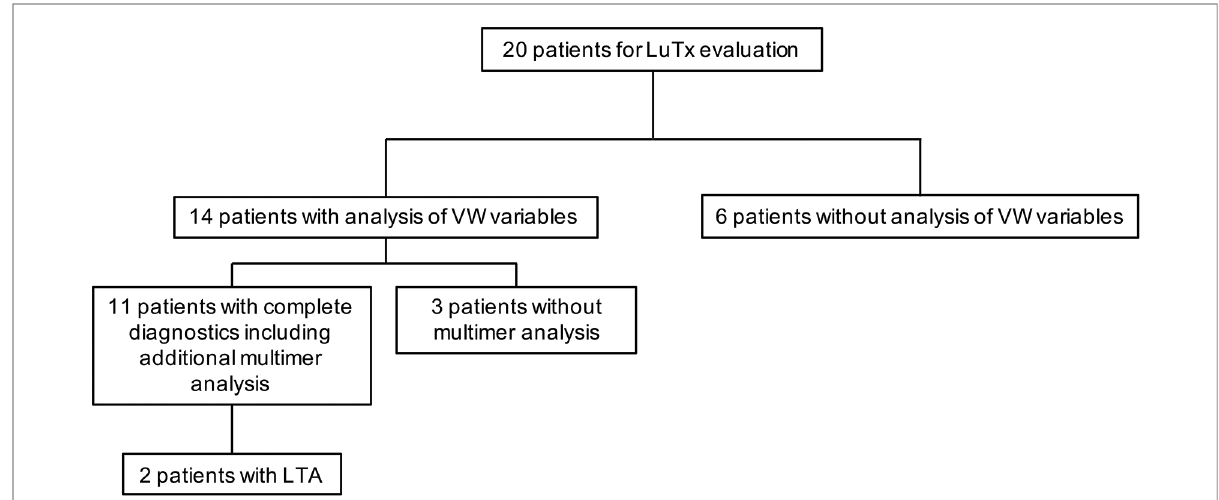
FIGURE 1 Diagnostic workup. The indicated VW variables include von Willebrand factor activity (VWF:Ac) and von Willebrand factor antigen (VWF:Ag). LTA, light transmission aggregometry; LuTx, lung transplantation; VW, von